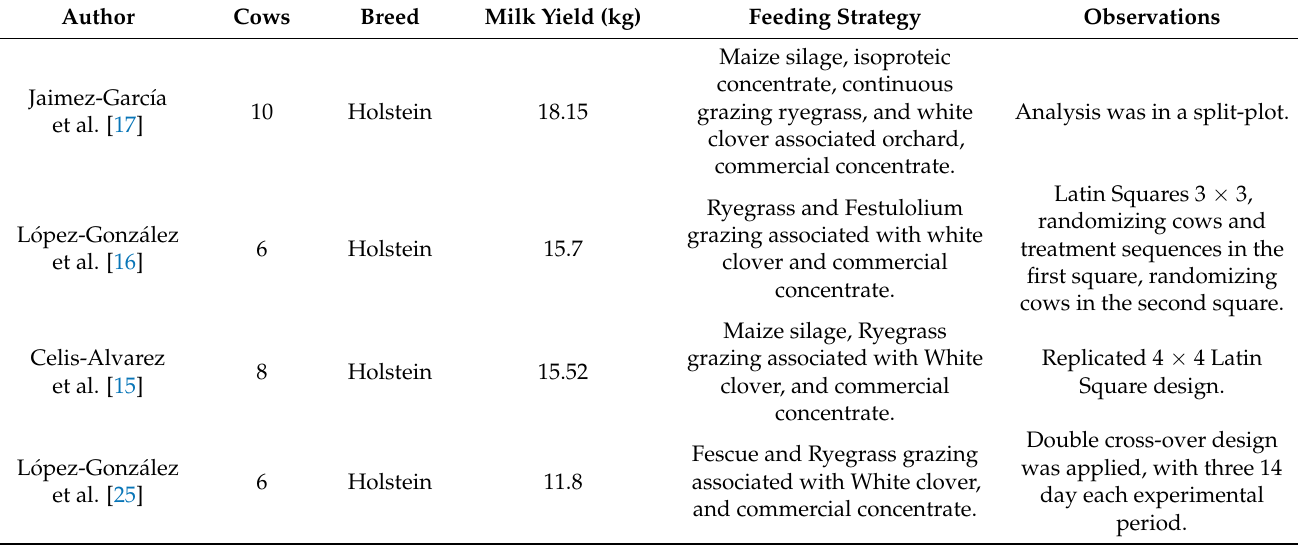
Table 1. Research studies published previously, which were based on determining the different feeding strategy systems management and scenarios.